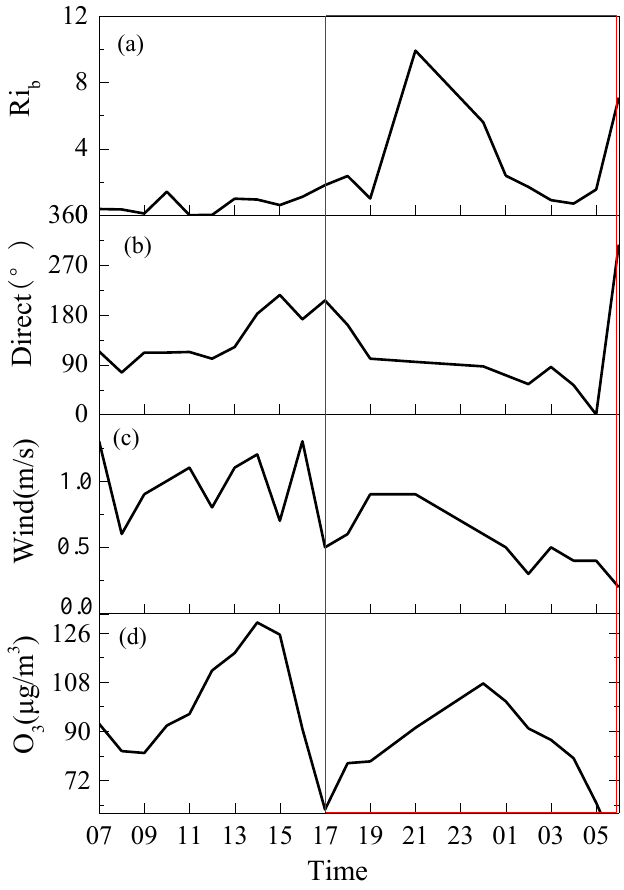
Figure 4. Characteristics of the variation in the bulk Richardson number (Ri b ) ( a ), wind direction ( b ), wind speed ( c ), and O 3 concentration ( d ) from 8 to 9 April 2020.